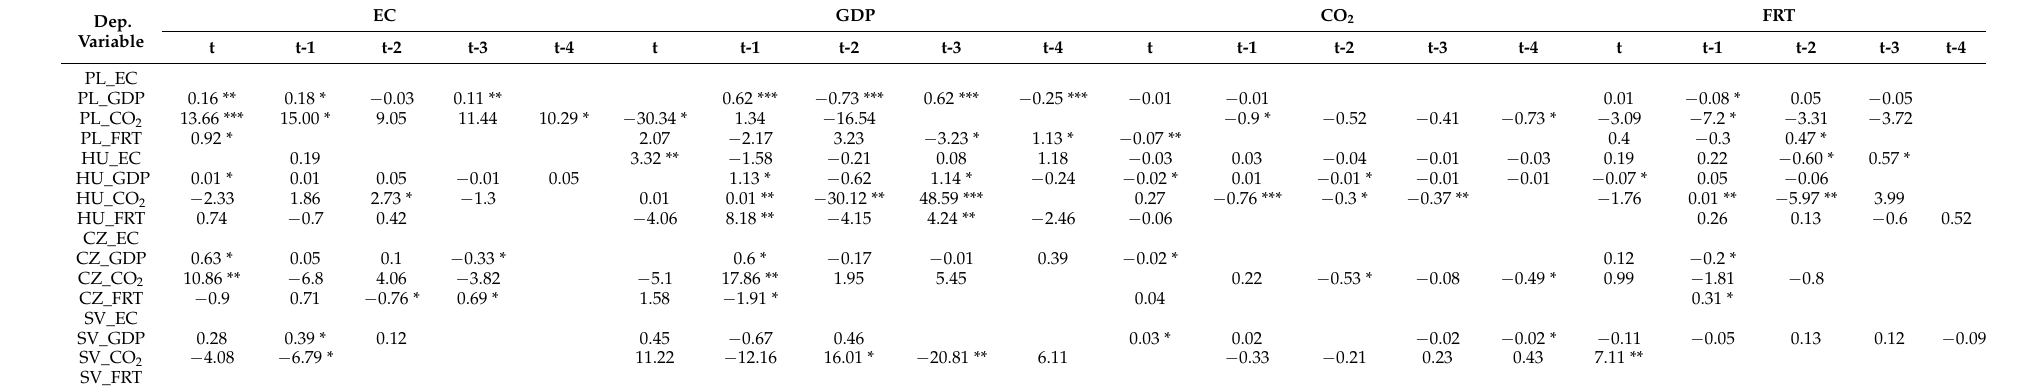
Table 7. Short-run